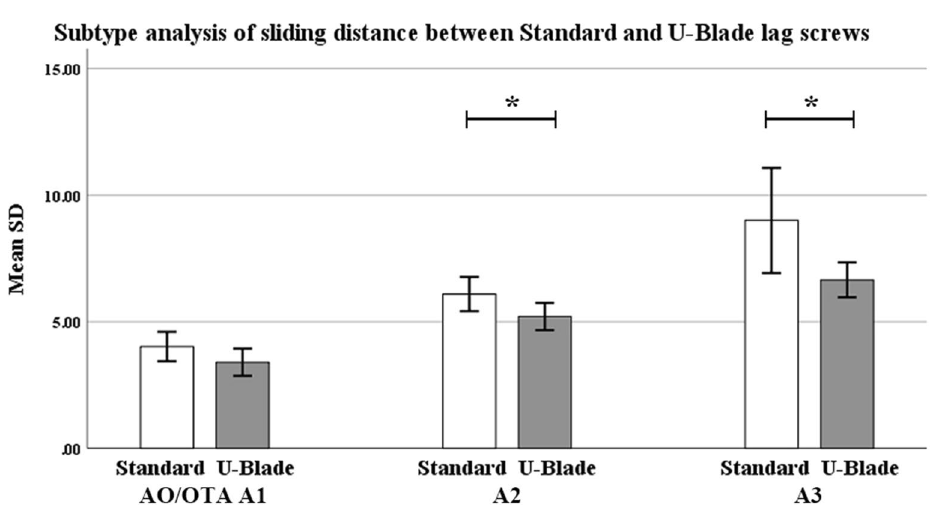
Figure 8. Subtype analysis of sliding distance between the groups in one year. * Significantly different in A2 and A3 at p <